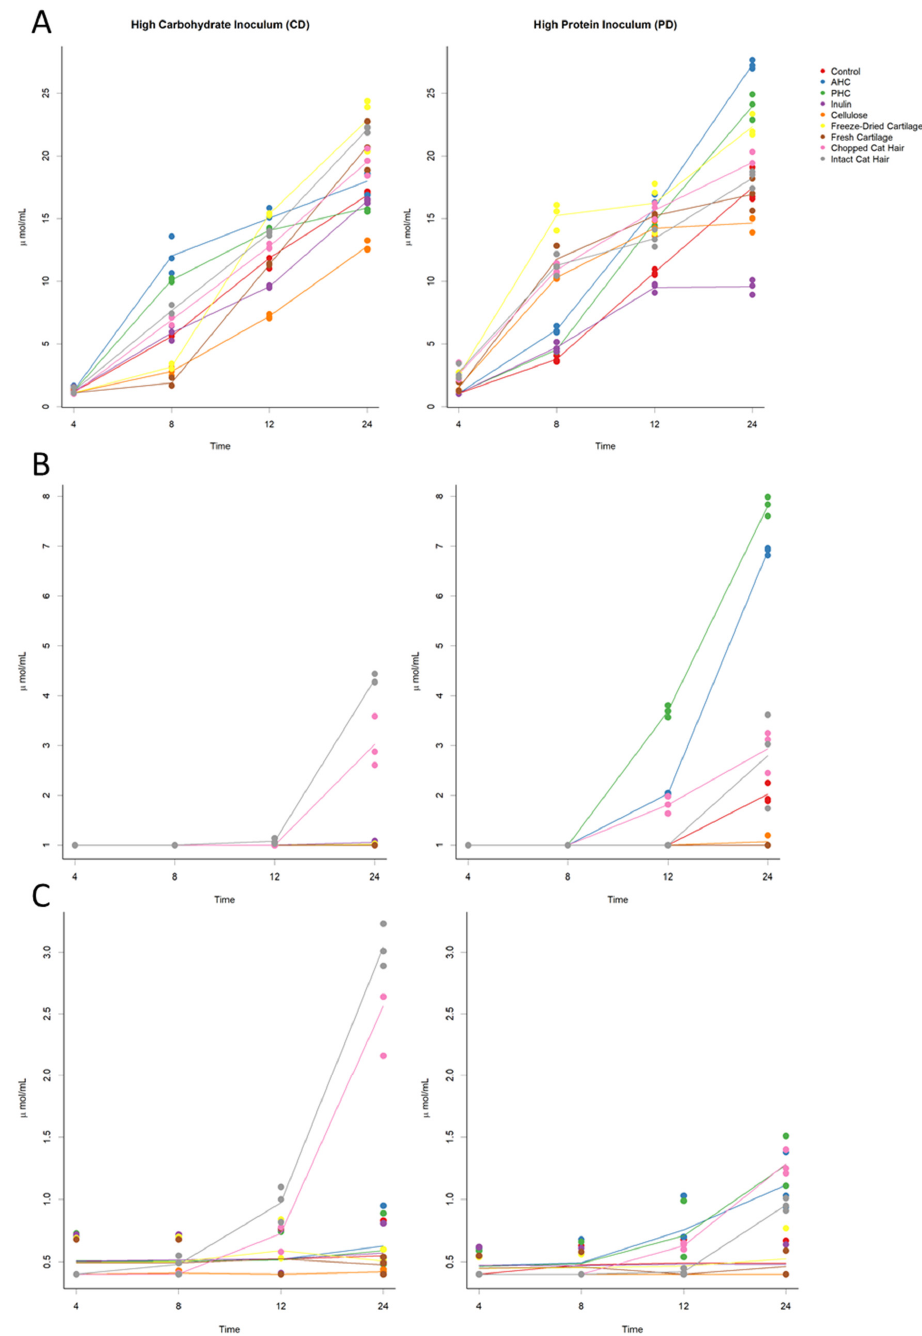
Figure 1. ( A – C ). Scatter plots with mean lines of ( A ) acetate ( B ) butyrate and ( C ) propionate concen- trations. Time (hours) is along the x -axis and organic acid concentration along the y -axis (µmol/mL). Each graph depicts both high protein faecal inoculum (PD) and high carbohydrate faecal inoculum (CD) and the changes that occurred over 24 h of fermentation. Each point (coloured circle) represents an individual replicate, and each line shows the mean for each substrate. Control samples are denoted by a red line, AHC (ANZCO hydrolysed collagen) by a blue line, PHC (Peptan hydrolysed collagen) by a green line, cellulose by an orange dashed line, inulin by a purple line, freeze-dried cartilage by a yellow line, fresh cartilage by a brown line, chopped cat hair by a pink line, and intact cat hair by a grey